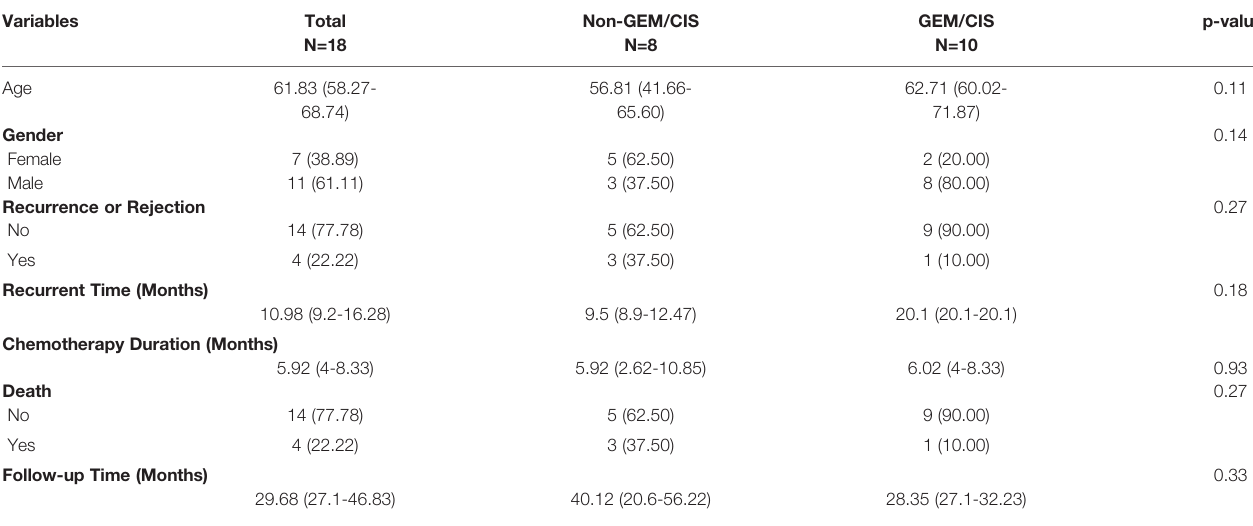
TABLE 3 | Baseline Characteristics of Evaluable Patients.